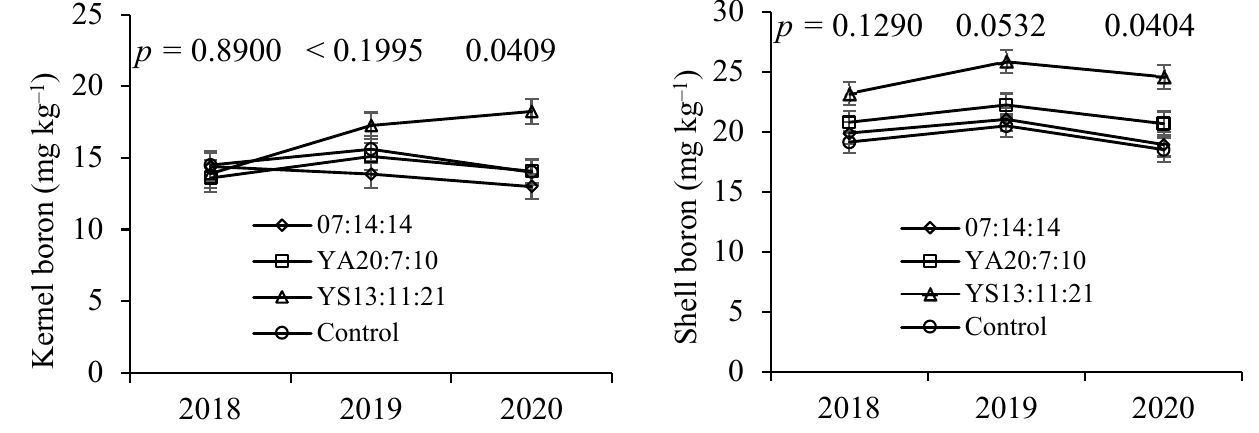
Figure 5. Boron concentrations in kernel and shell as a response to fertilisation treatments. Error bars are the standard errors.